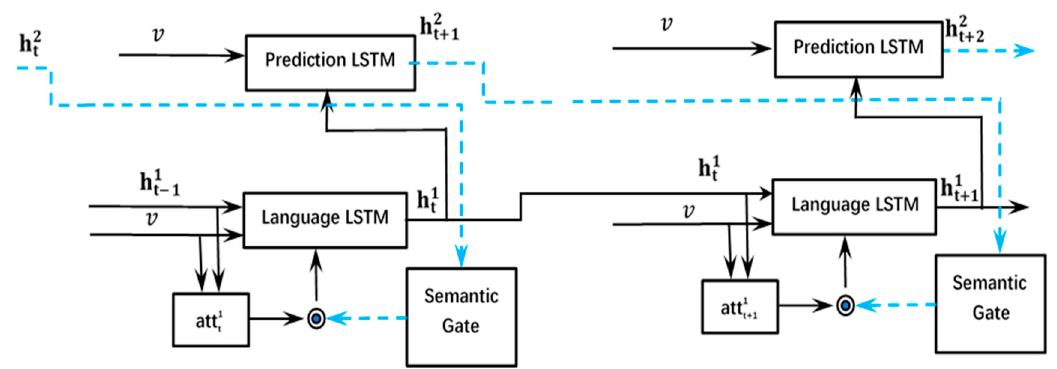
Figure 6. The architecture of the BiTLSTM.